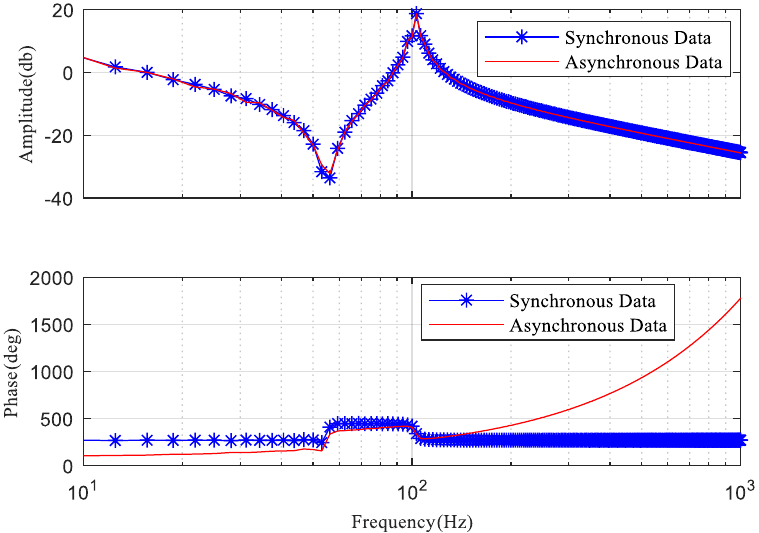
Figure 5. Spectrum of the frequency response in simulation.